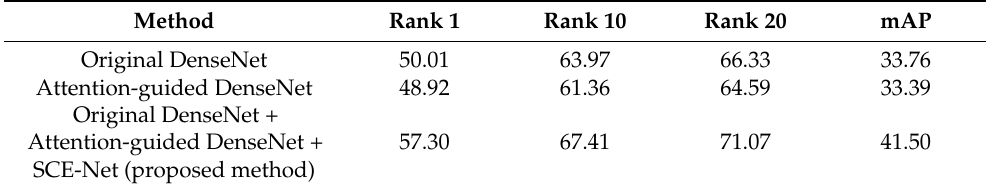
Table 8. Comparisons on the ReID accuracies of the original DenseNet, attention-guided DenseNet, and proposed OADE-Net with SYSU-MM01 (unit: %).